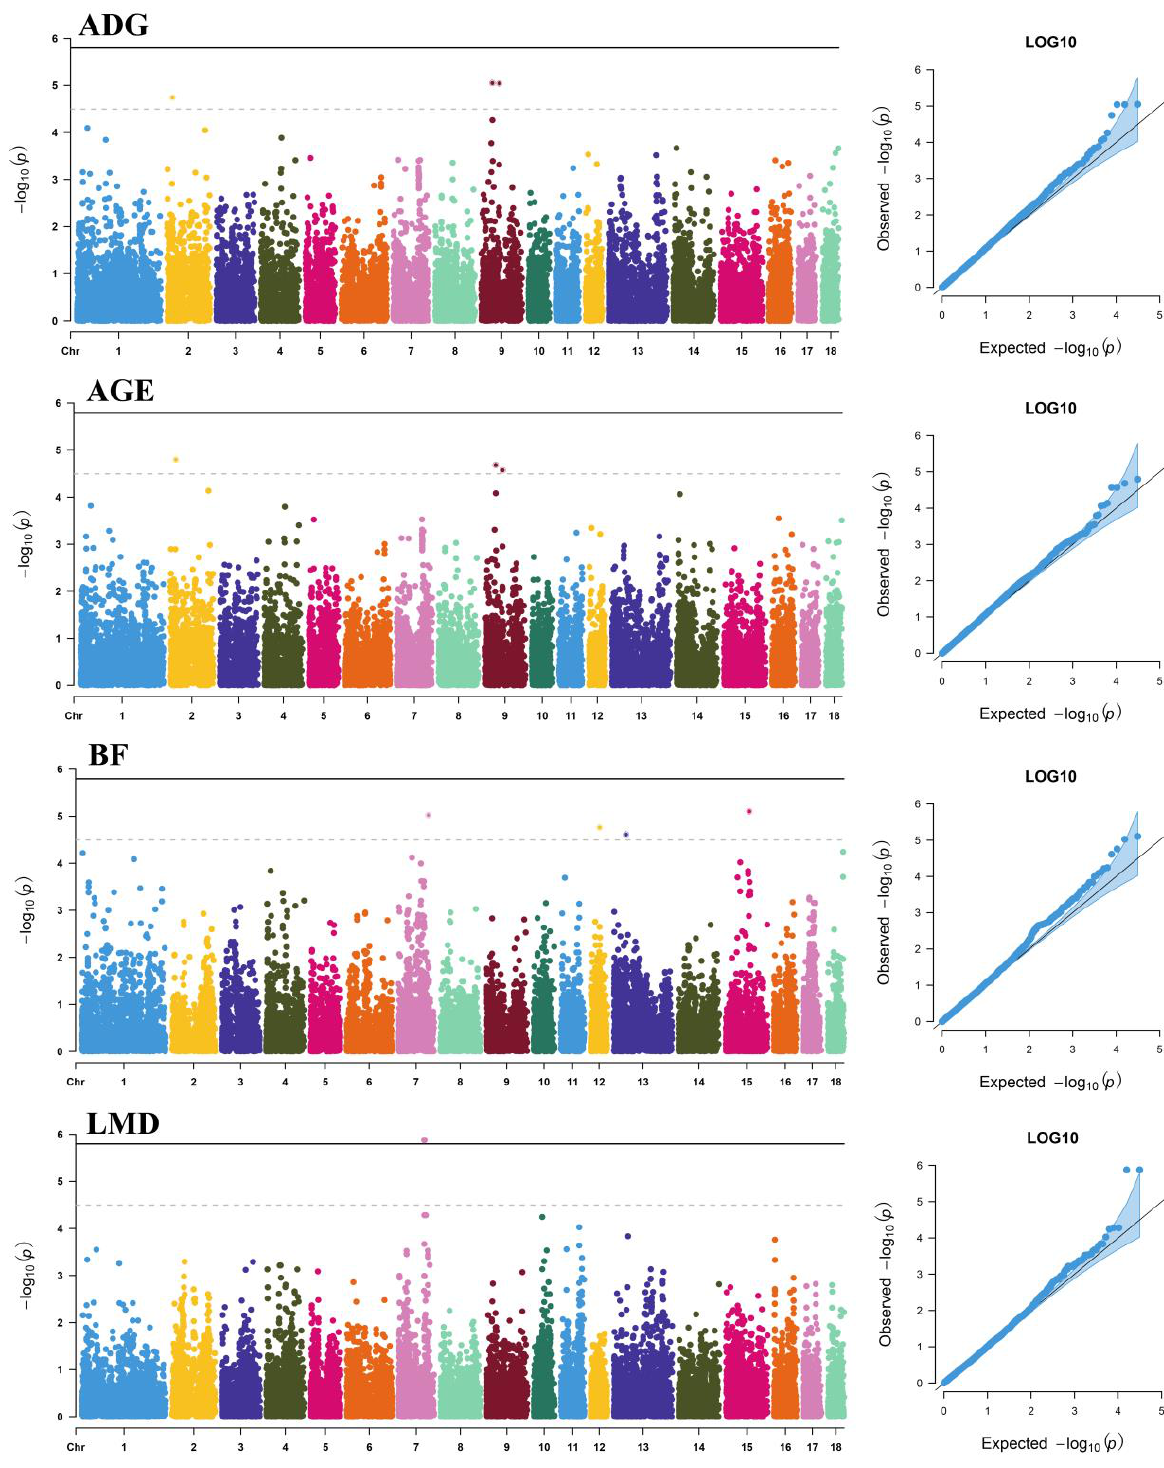
Figure 1. Manhattan plots and Q - Q plots of SNP additive effects for average daily gain (ADG), adjusted age at 100 kg (AGE), backfat thickness at 100 kg (BF), and loin muscle depth at 100 kg (LMD) traits of Duroc pigs. The X -axis shows the physical positions of the SNPs on each chromosome; the Y -axis shows the significance levels ( − log 10 p -values). The solid line indicates genome-wide significance ( p < 1.59 × 10 − 6 ); the dashed line shows suggestive significance ( p < 3.19 × 10 − 5 ). The Q - Q plots show the observed vs. expected log p